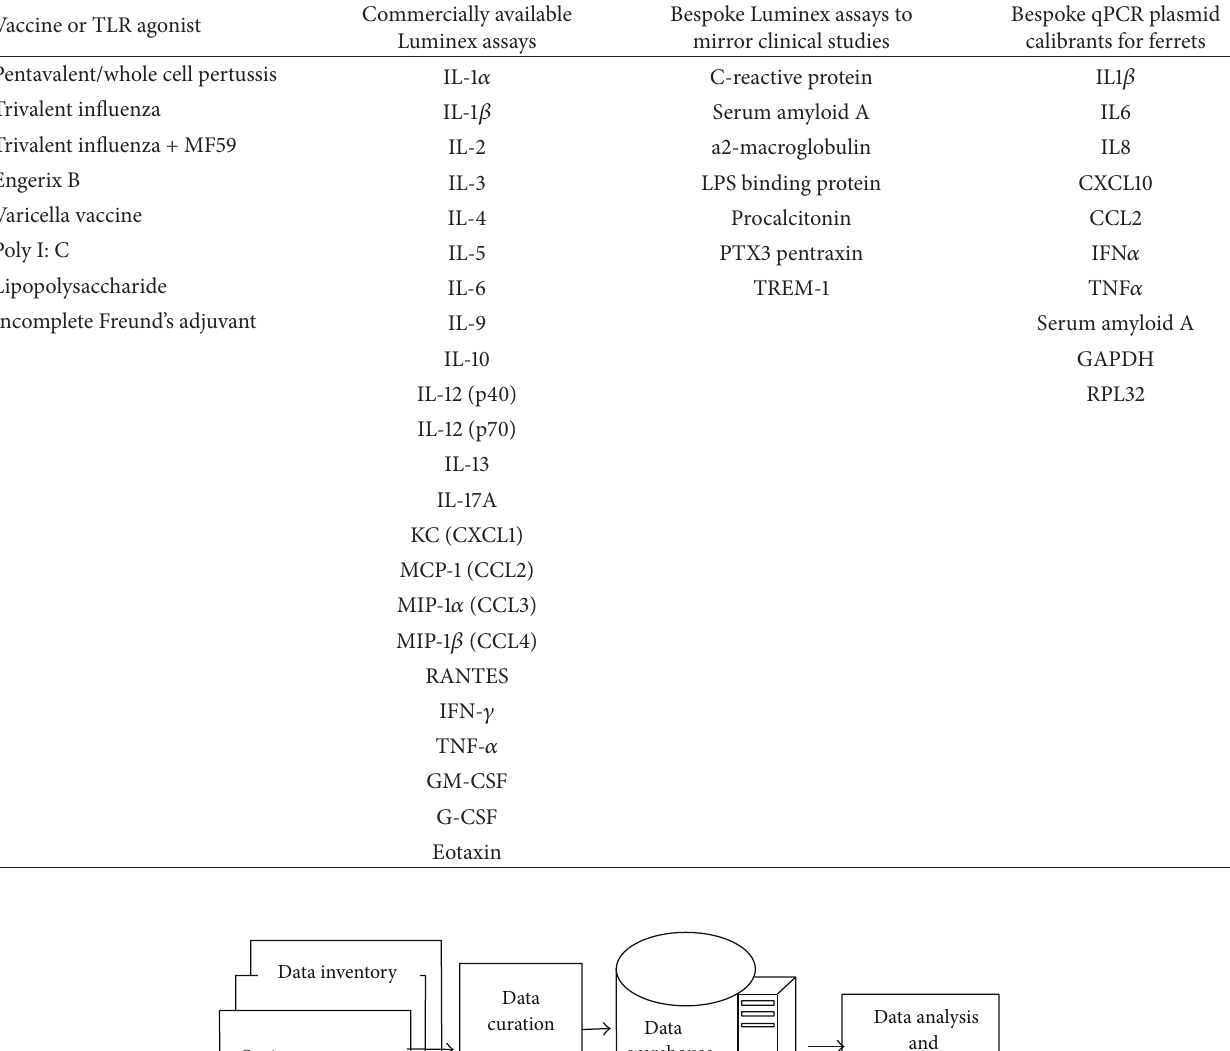
Table 2: Harmonized minimum data set of immune parameters for cross species evaluation of responses to adjuvanted vaccines and TLR agonists.